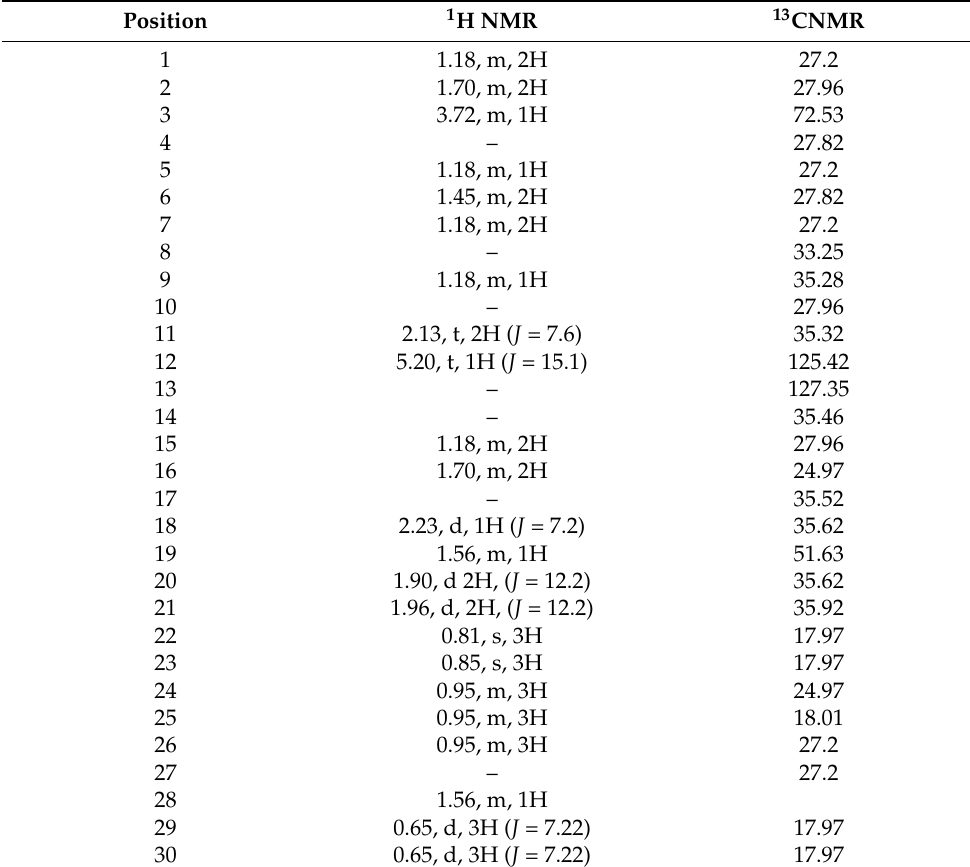
Table 2. 1 HNMR and 13 CNMR data of compound SA-4.